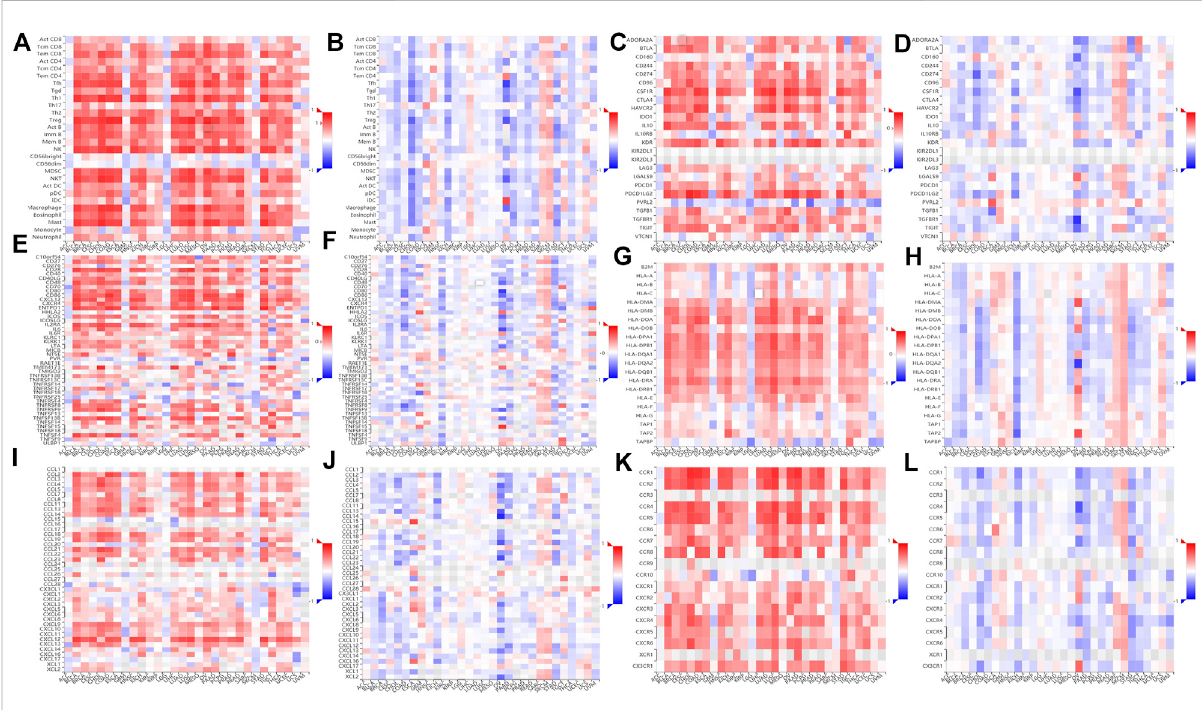
FIGURE 7 The relationshipbetweenthemethylation level of ZEB2 and immune in fi ltration. (A) The correlation between TILsand ZEB2 expression. (B) The correlation between TILs and ZEB2 methylation. (C) The correlation between immunosuppressants and ZEB2 expression. (D) The correlation between immunosuppressants and ZEB2 methylation. (E) The correlation between immune activators and ZEB2 expression. (F) The correlation between immune activators and ZEB2 methylation. (G) The correlation between MHC molecules and ZEB2 expression. (H) The correlation between MHC molecules and ZEB2 methylation. (I) The correlation between chemokines and ZEB2 expression. (J) The correlation between chemokines and ZEB2 methylation. (K) The correlation between receptors and ZEB2 expression. (L) : The correlation between receptors and ZEB2